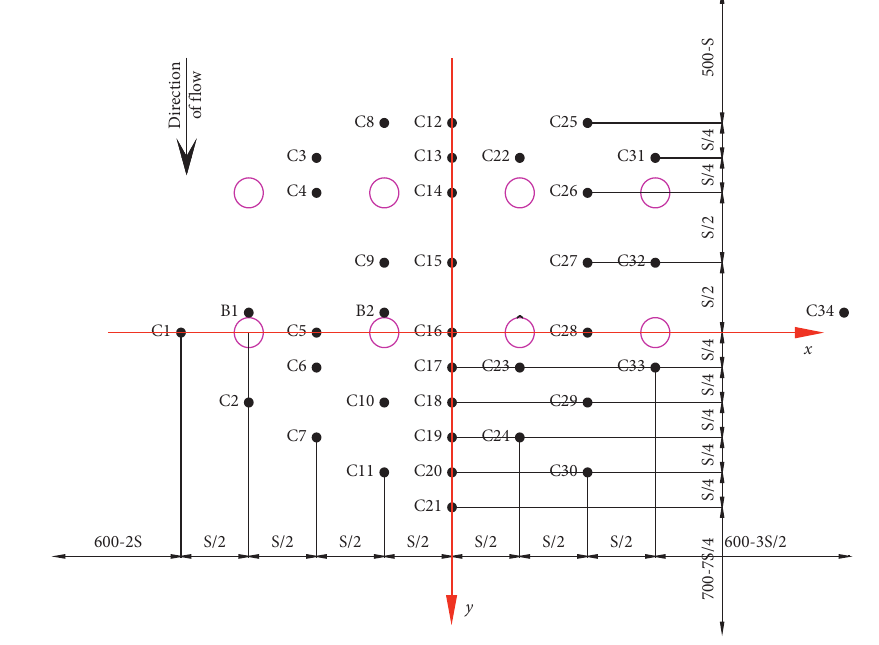
Figure 3: Model design